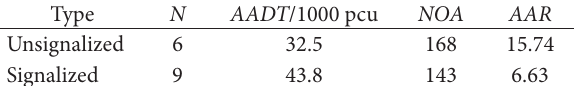
Table 3. AAR estimation for intersections in Wenchang Rd.